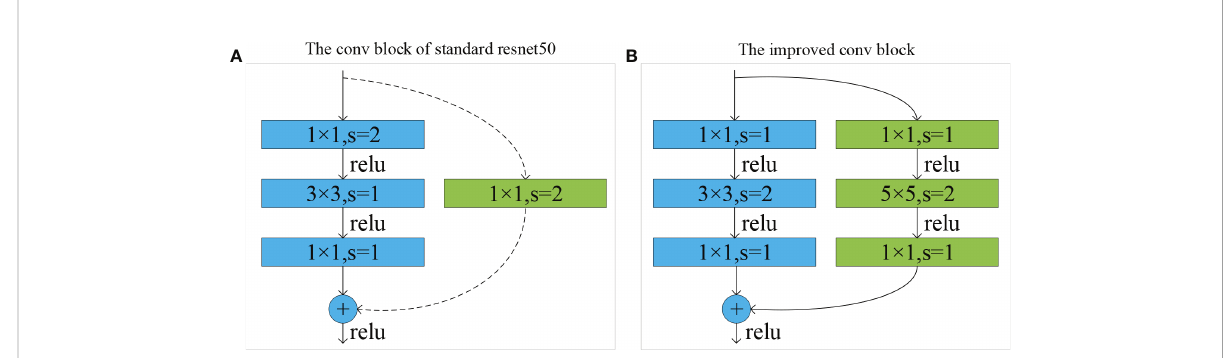
FIGURE 4 (A) Conv-block of standard resnet-50 and (B) improved residual block. “ ⊕ ” denotes add, which is the element-by-element addition of the values. “ s ” is the acronym for Stride, which indicates the step size when the convolution kernel traverses the feature map.